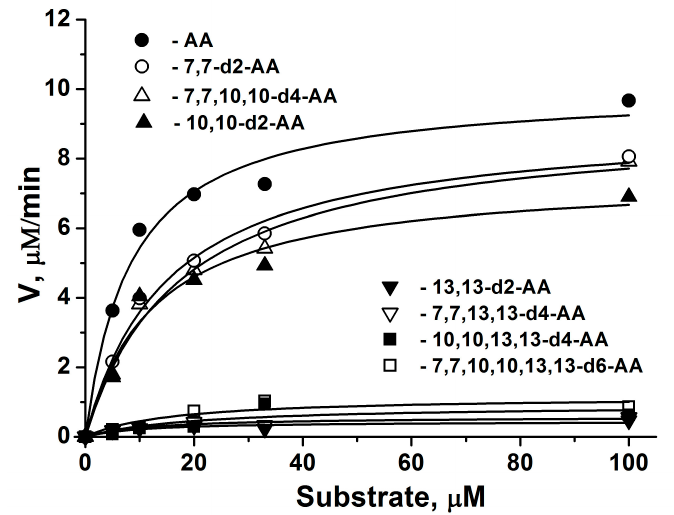
Figure 1. Steady state kinetics of COX-2 with arachidonic acid (AA) and deuterated arachidonic acids. Details are described in Experimental Procedures. Experiments were conducted in triplicate. Standard deviations are indicated in Table 1. Table 1. Kinetic parameters for the reaction(s) of COX-2 and 15-LOX-2 with AA and deuterated AA isotopologues.